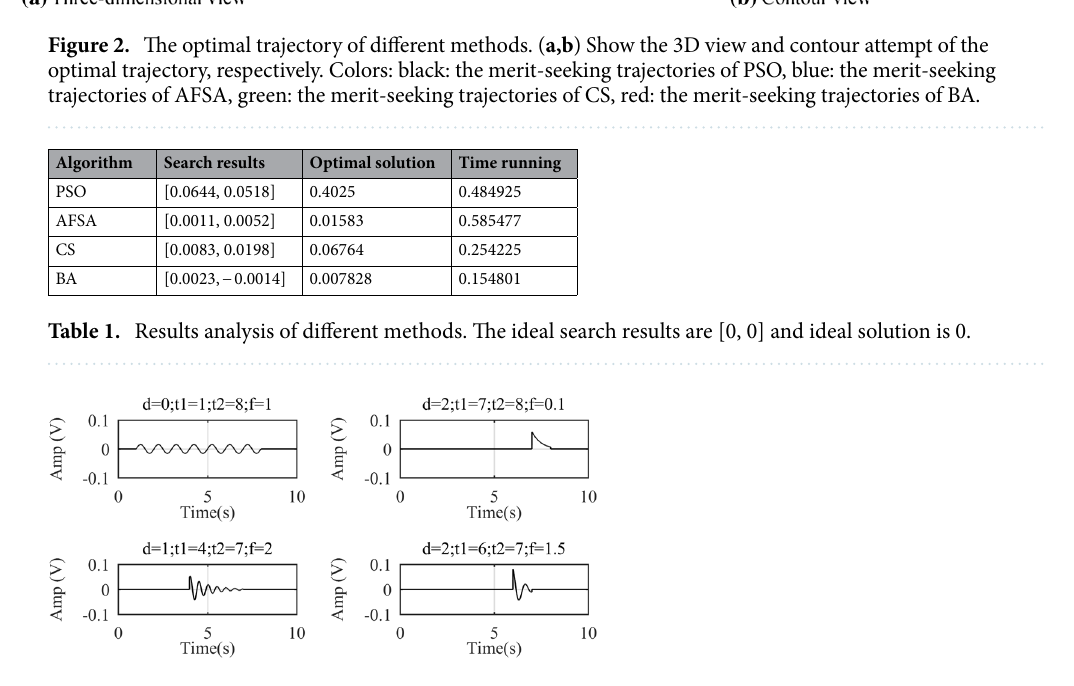
Figure 3. Time domain waveforms of g-atoms with different